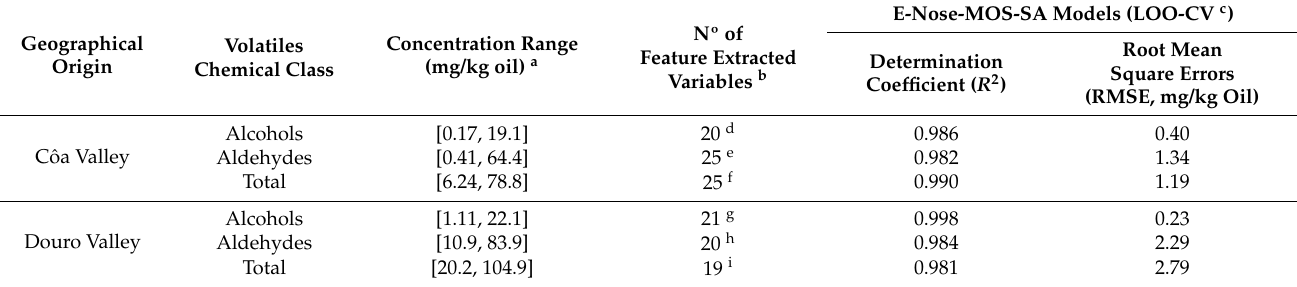
Table 4. Quantification of the contents of aldehydes and alcohols emitted by olive oils originated from C ô a Valley (36 oils) or Douro Valley (31 oils), and of the respective total volatiles content (alcohols + aldehydes + alkanes + alkenes + esters + ethers + ketones + terpenes): predictive perfor- mance of the MLRMs developed based on sub-sets of feature extracted variables from the electrical resistance signal curves acquired by the nine-MOS sensors comprised on the lab-made E-nose, which were selected using the SA